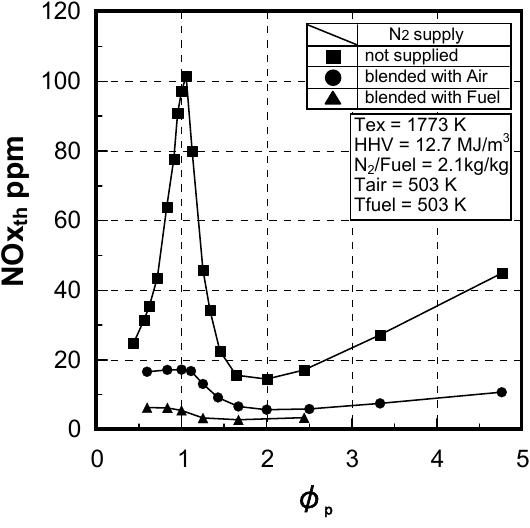
Figure 67. Effect of nitrogen injection on thermal-NOx emission characteristics in two-stage combustion, using small diffusion